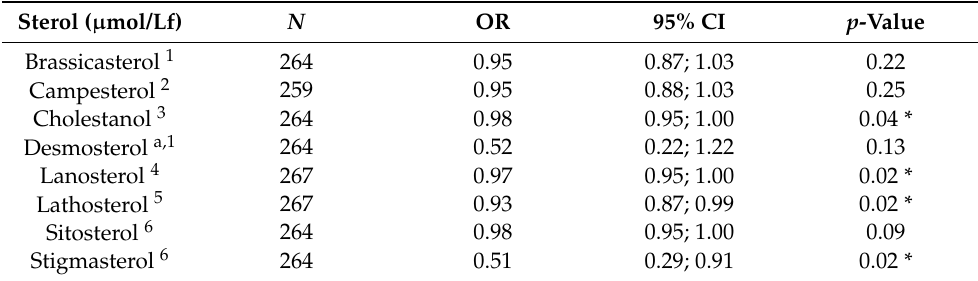
Table 5. Results of the multiple logistic regression analyses using the selected sterols for eczema. Separate models were made for each individual sterol. Non-cholesterol sterol concentrations were adjusted for creamatocrit. Sterol ( µ mol/Lf) N OR 95% CI p -Value